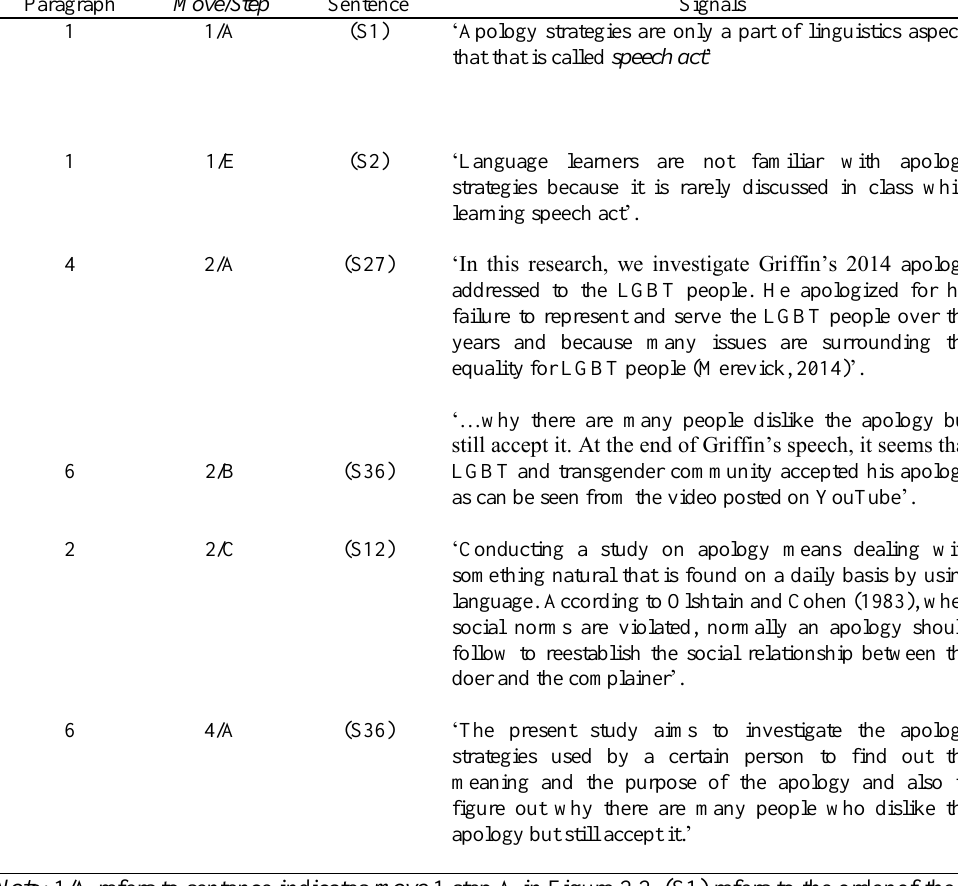
Move and Step in Research Article Introduction (RAI) in article 1.1 Research